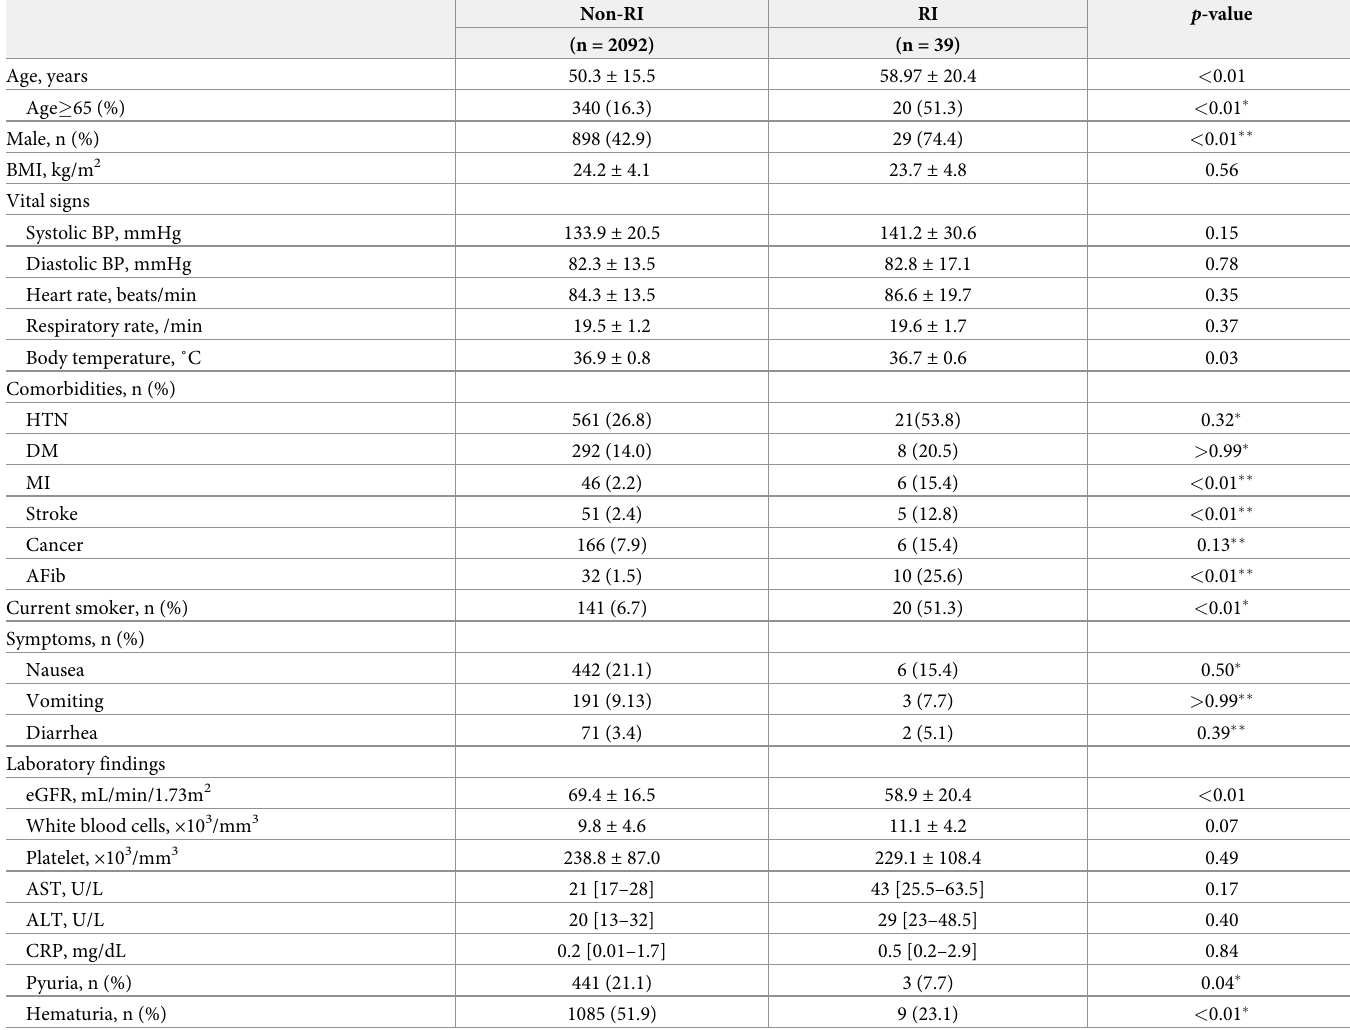
Table 1. Comparison of the baseline characteristics between the two